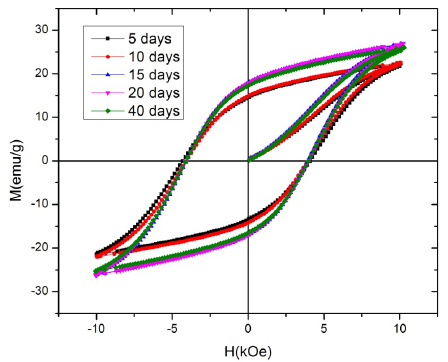
Figure 5. M-H curves of the specimens from a billet extruded from mechanically-milled gas atomized powders aged for 5, 10, 15, 20 and 40 days at 200 °C in